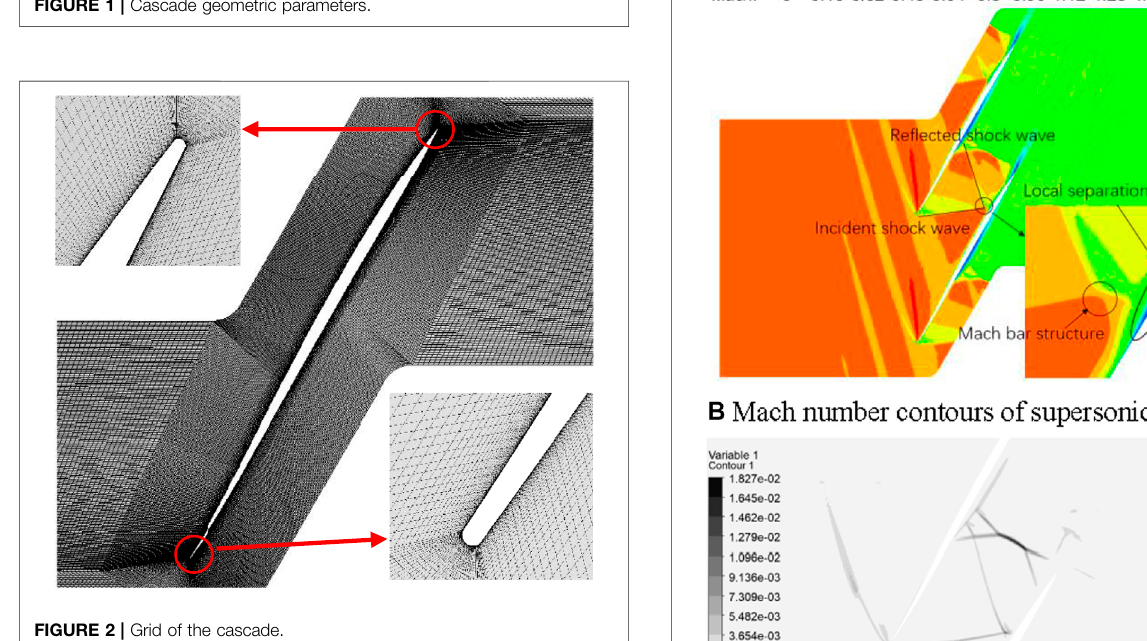
FIGURE 1 | Cascade geometric parameters.